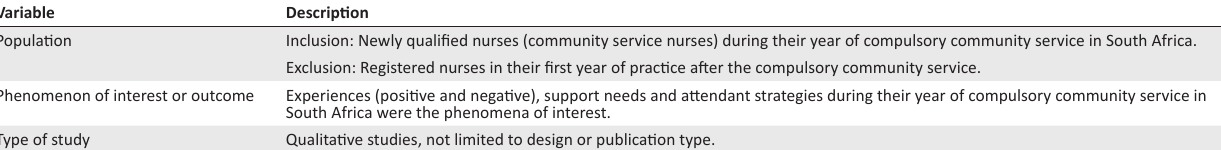
TABLE 1: Inclusion and exclusion